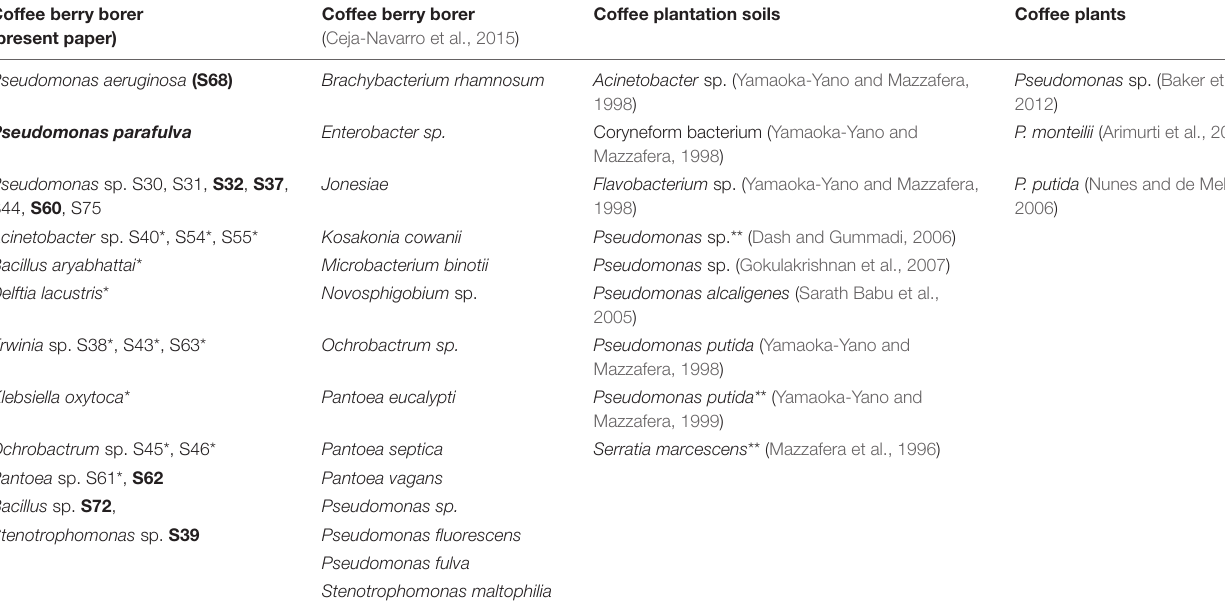
TABLE 3 | Strains with caffeine N-demethylation genes and/or metabolites isolated from coffee berry borers, coffee plantation soils, and coffee plants. Coffee berry borer (present